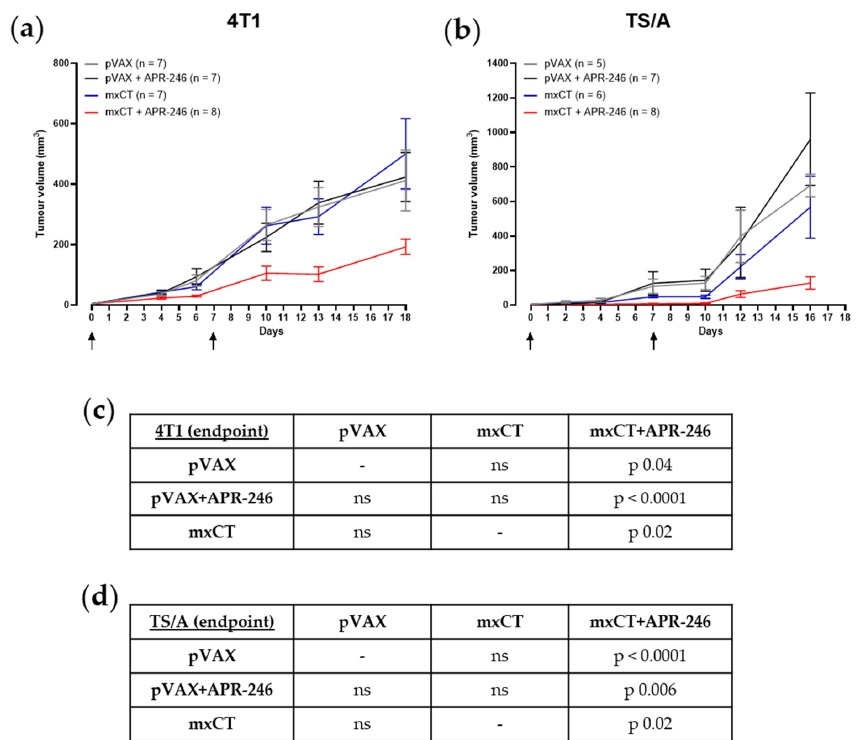
Figure 4. Therapeutic effect of APR-246 and anti-xCT immunization on mouse mammary tumors. Average tumor growth rate (expressed as tumor volume in mm 3 ; mean ± SEM for each group) of s.c. ( a ) 4T1- and ( b ) TS/A-induced tumors in BALB/c mice electroporated with pVAX control plasmid alone (grey lines) or in combination with APR-246 treatment (100 mg/Kg i.p. daily, starting when the tumor was palpable; black lines); immunized with mxCT plasmid alone (blue lines) or in combination with APR-246 treatment (red lines); “n” indicates the number of animals per group. The black arrows indicate the immunization timing. ( c , d ) Tables reporting the statistical differences between the experimental groups of mice challenged with 4T1 and TS/A, respectively, at the endpoint, analyzed with the Student’s t test (ns = not